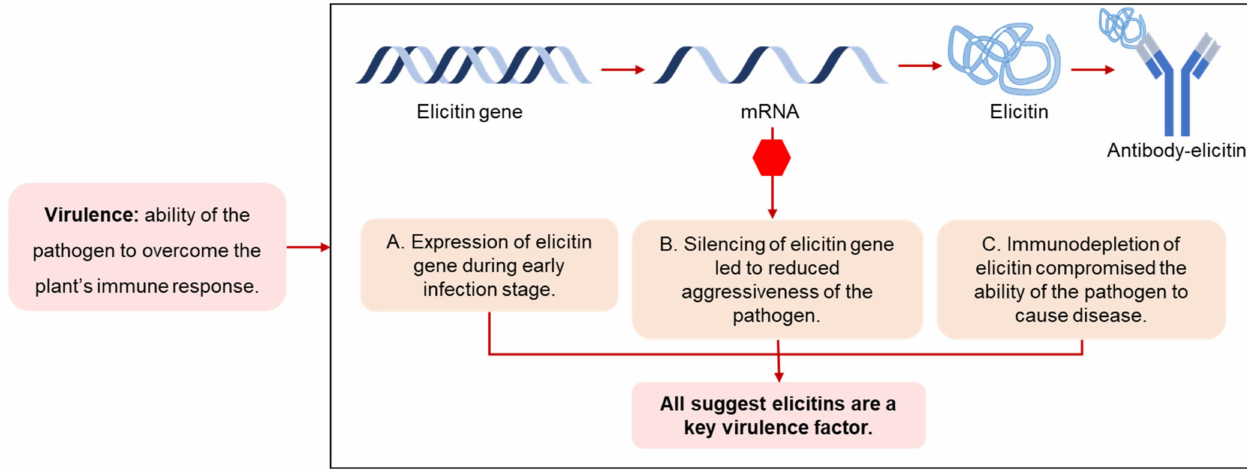
Figure 2. Compilation of three independent studies that support the role of elicitins as a virulence factor. (A ) Expression of the beta-cinnamomin gene (elicitin of P. cinnamomi ) during pathogen growth and lupin infection suggested a vital role of the protein in pathogen development and in the early stages of root infection [24]. ( B ) Inhibition of the expression of the beta-cinnamomin gene reduced the pathogenicity of P. cinnamomi in cork oak [27]. ( C ) Fagus sylvatica roots that were pre-incubated with an alpha-plurivorin antibody remained healthy in contrast to the plants that were not exposed to the antibody. Immunodepletion of alpha-plurivorin (elicitin of Phytophthora plurivora ) compromised the penetration capacity of the pathogen [28].